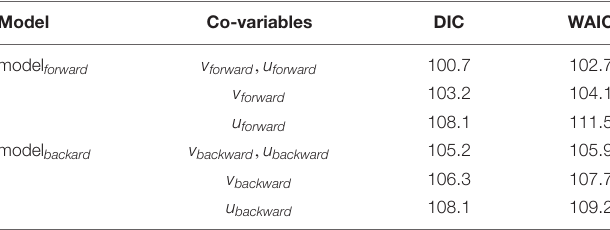
TABLE 1 | Model selection using DIC (deviance information criterion) and WAIC (Watanabe – Akaike information criterion).